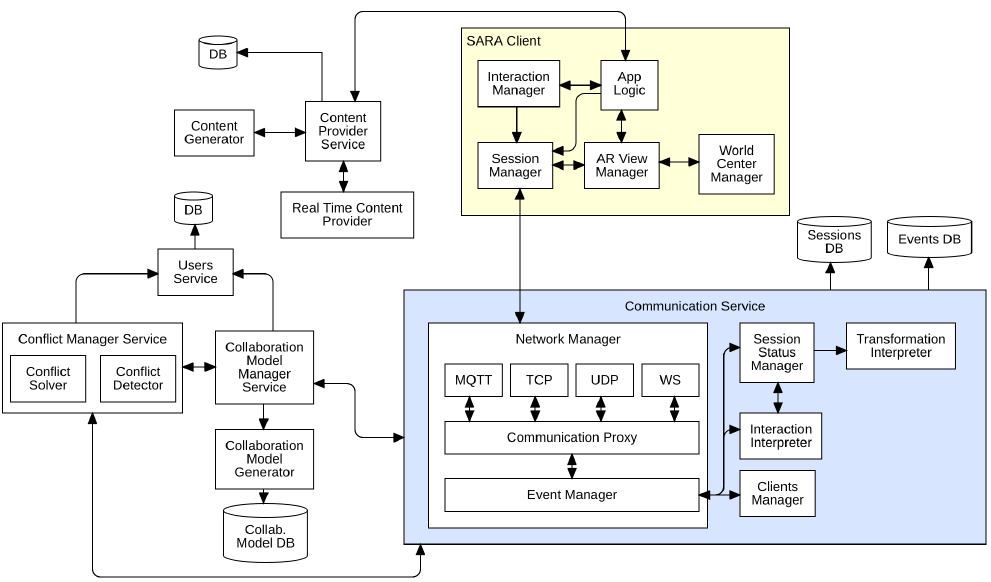
Figure 4. Service-oriented architecture diagram for